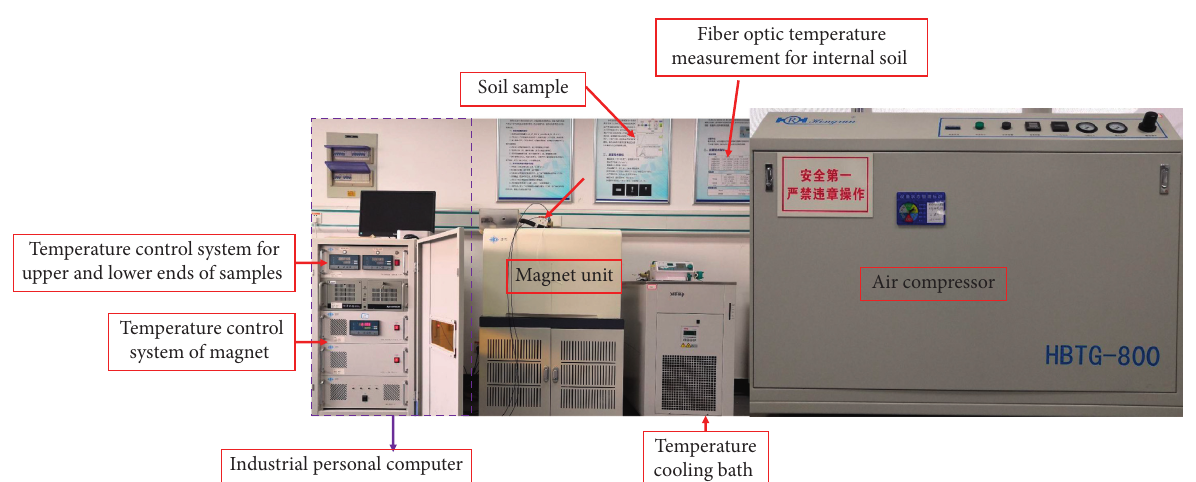
Figure 2: The unfrozen water content test system.